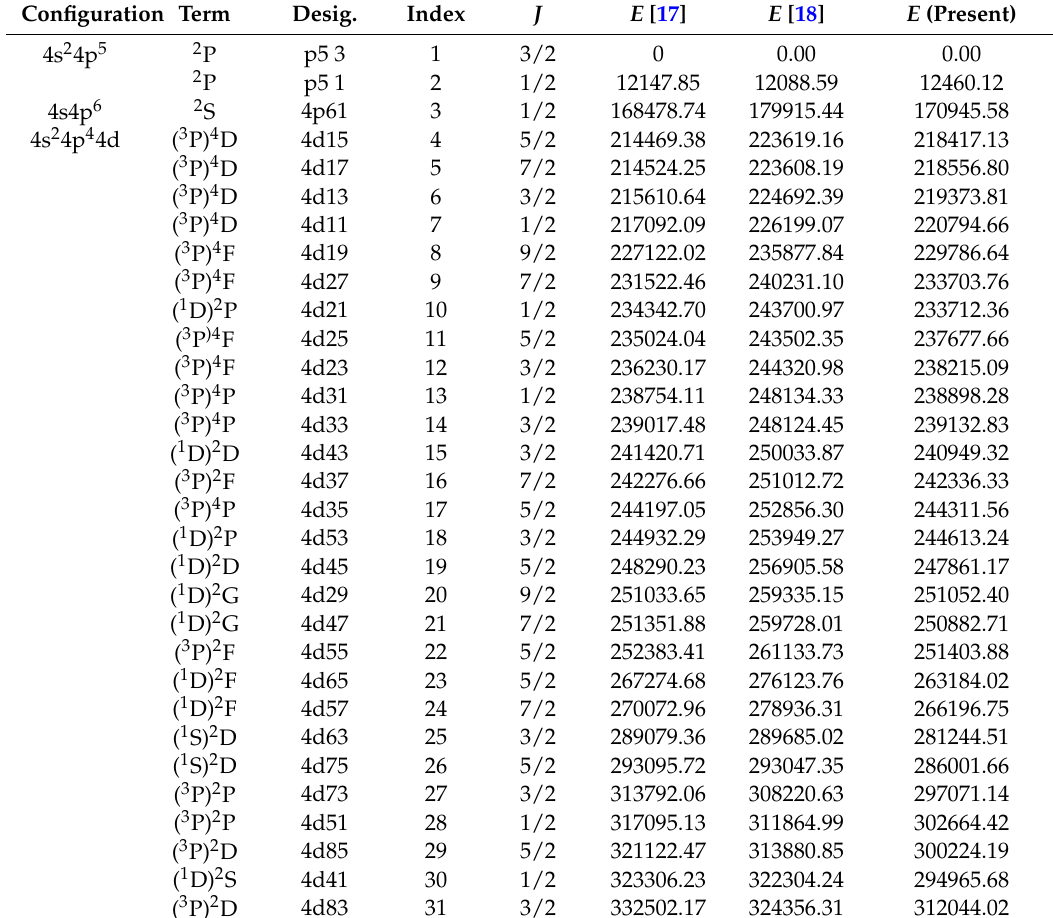
Table 9. Comparison of level energies E (cm − 1 ) for Y V calculated with the MCDF2 method of Singh et al. [17] and the GRASP3 method of Aggarwal and Keenan [18] with present experimental energies. Index numbers are those used in